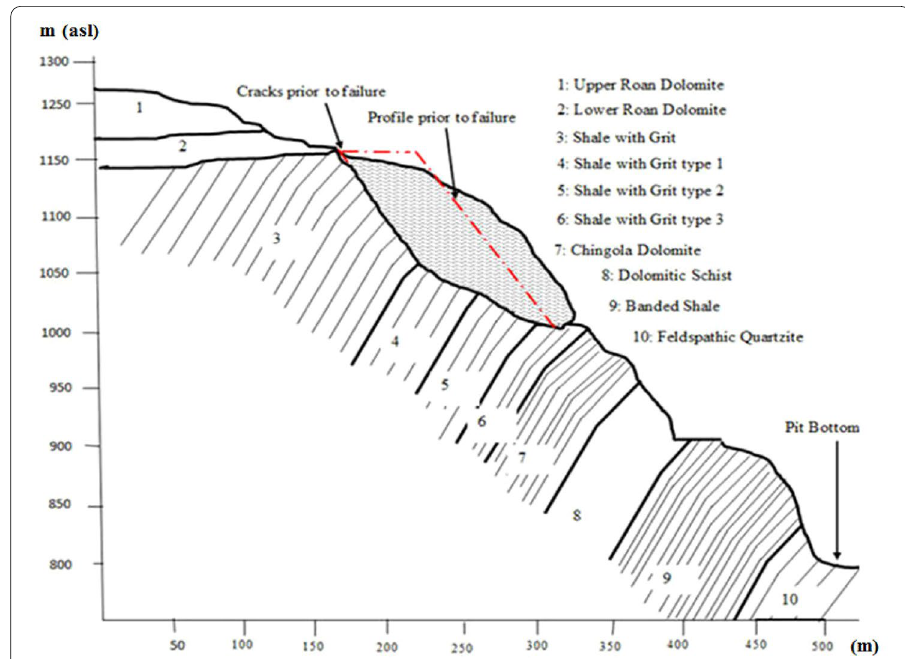
Fig. 6 Geology setting at the rock slope